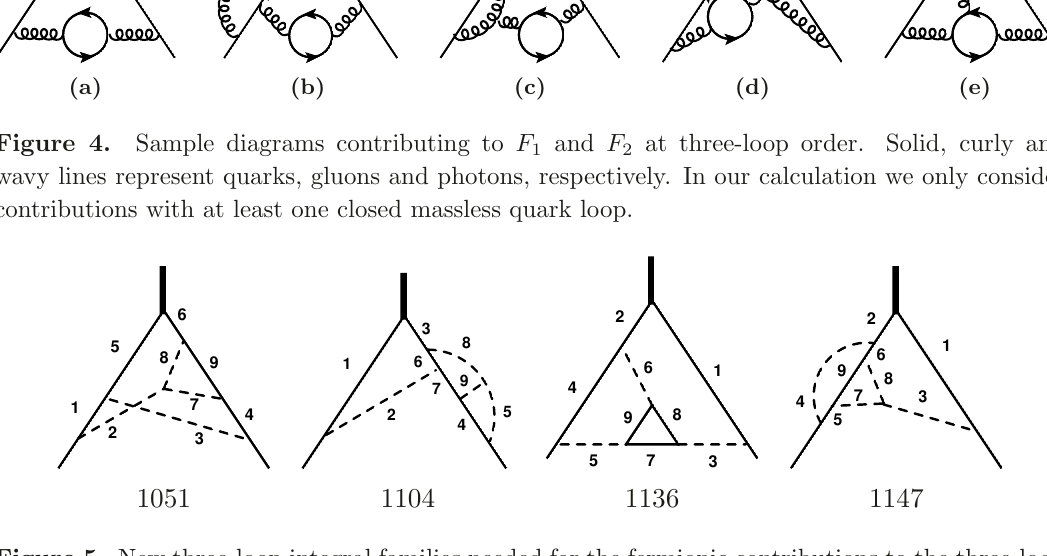
Figure 5. New three-loop integral families needed for the fermionic contributions to the three-loop vertex corrections. Solid and dashed lines represent massive and massless lines, respectively. Thin external lines are on the mass shell and thick external lines carry the off-shell momentum q . For convenience we keep our internal numeration of the integral families, which is shown below the Feynman